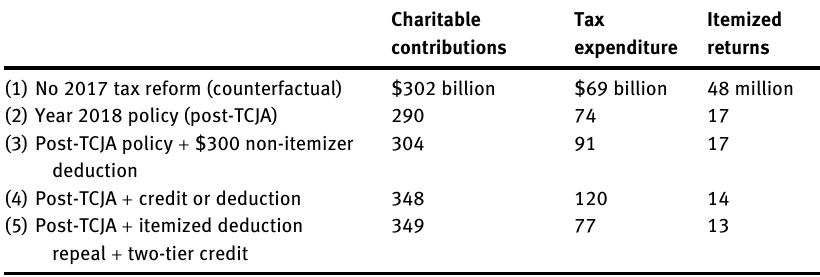
Table  : Simulated policy effects of TCJA and two-tier contribution tax